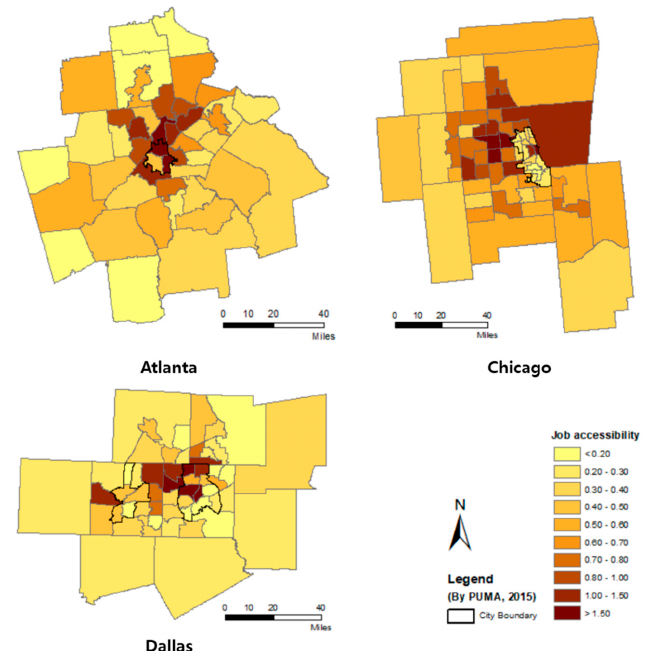
Figure 2. Job accessibility index in three metropolitan areas, 2015. Table 2. Probit model results of employment